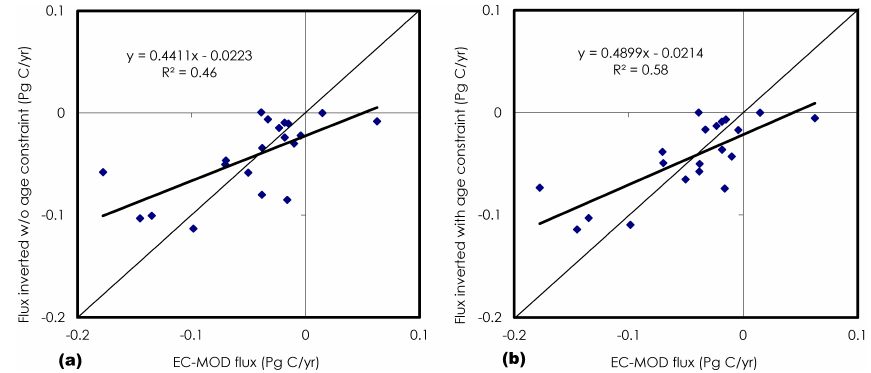
Fig. 5. CO 2 fluxes for 20 North America regions (region 9 to 28) estimated from two inverse approaches vs. the EC-MOD method. The inverse approaches are (a) inversion without age constraint and (b) inversion with age